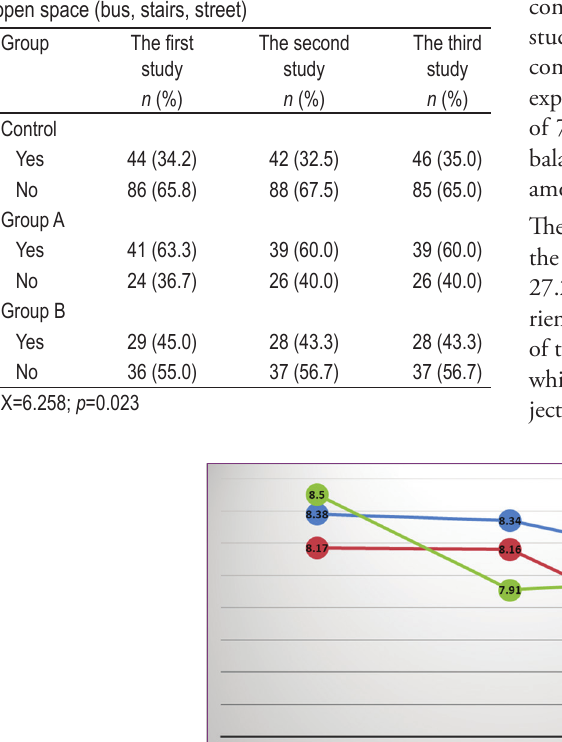
TABLE 11. The presence of anxiety due to possible fall in an